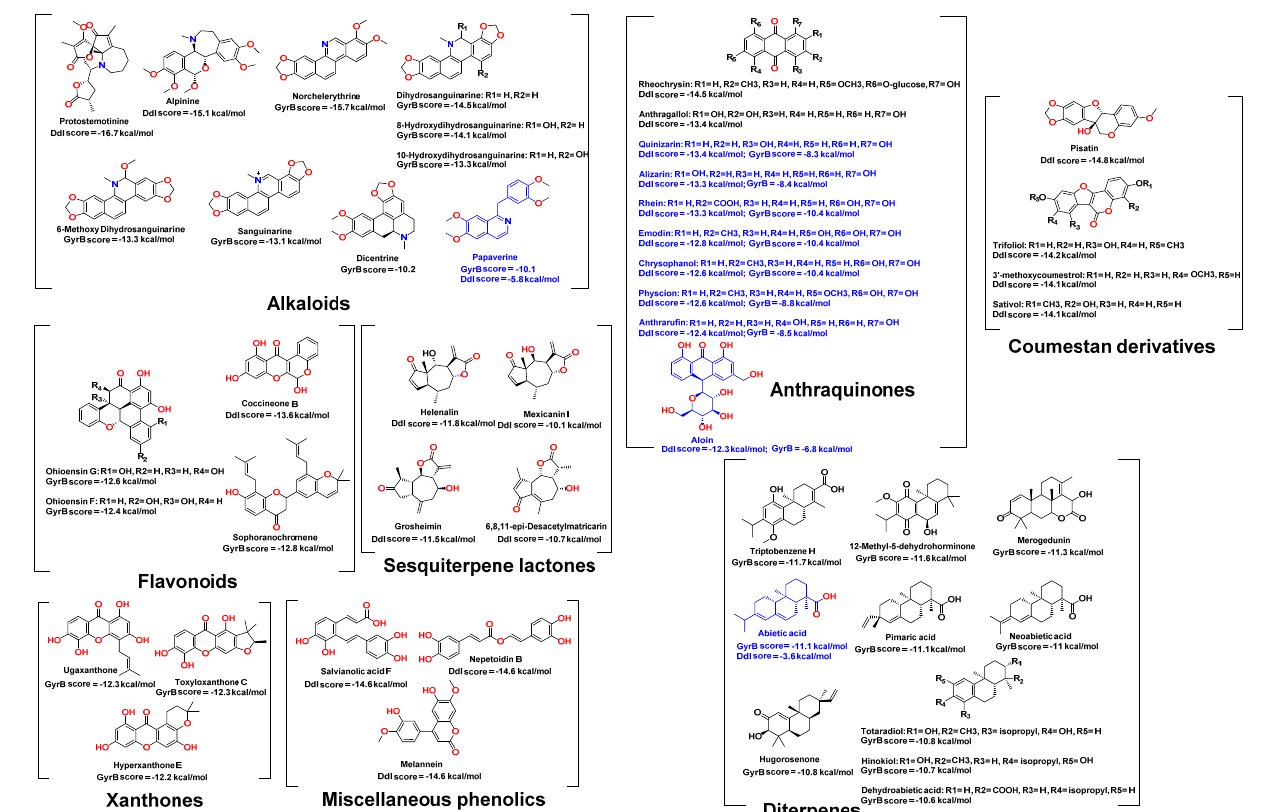
Figure 3. Top-scoring compounds retrieved from docking-based screening of AfroDb against E. coli Ddl-B and Gyr-B. The compounds were grouped according to their chemical classes and the docking scores against either Ddl-B or Gyr-B were presented under each compound (Ddl-B scores or Gyr-B scores, respectively). Blue-colored compounds were selected for in vitro testing.